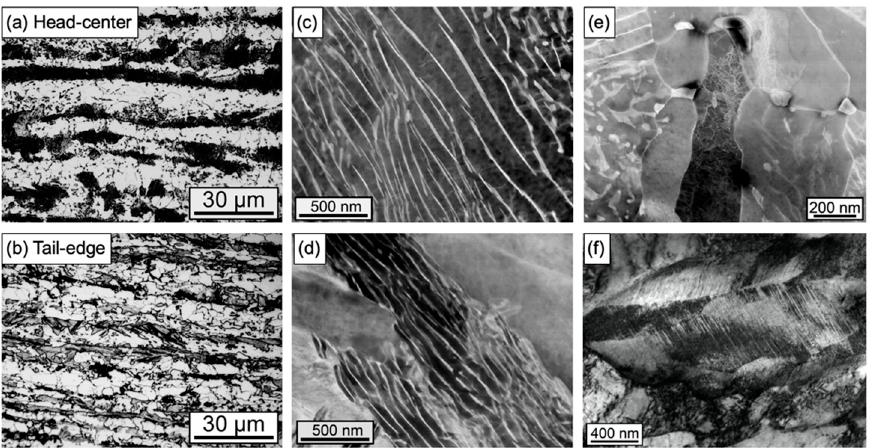
Figure 4. Microstructure in as hot rolled condition: ( a , b ) light optical microscopy; ( c , d ) TEM (Transmission electron microscope) details of lamellar pearlite; ( e , f ) TEM details of martensitic phases.